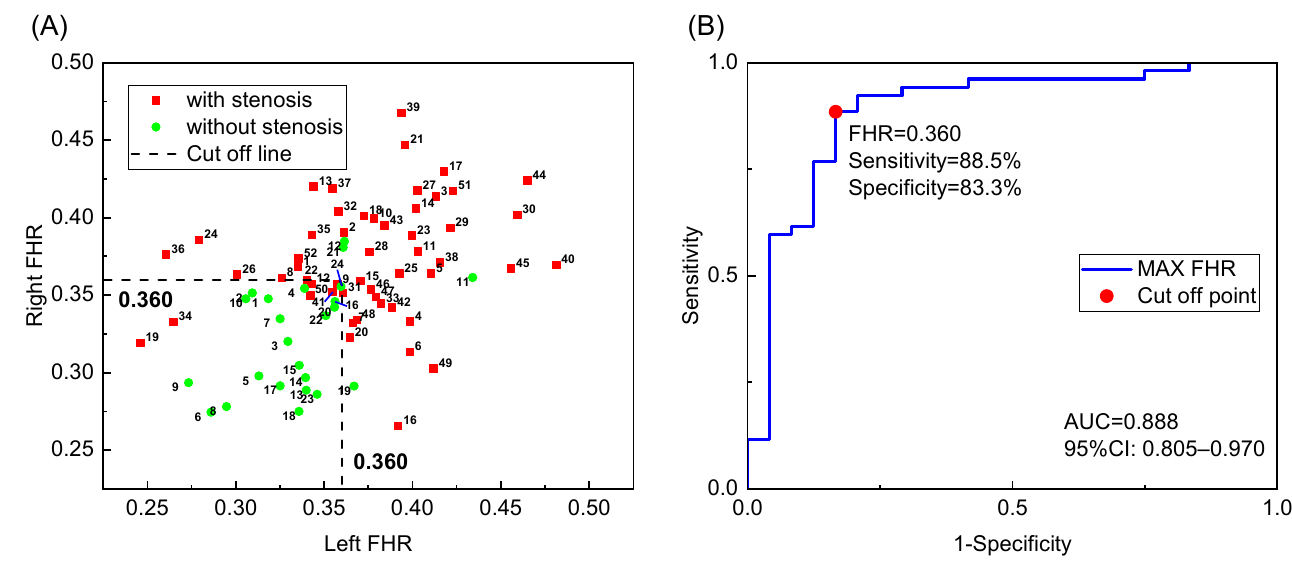
Figure 4. Diagnosis of the patients with and without IICAS: ( A ) FHR data of both sides; ( B ) receiver operating characteristic curve of IICAS diagnosis using the maximum FHR of both sides. FHR, first harmonic ratio; IICAS, intracranial internal carotid artery stenosis; AUC, area under the receiver operating characteristic curve; CI, confidence interval. Table 4. Results of the logistic regression (N = 76).